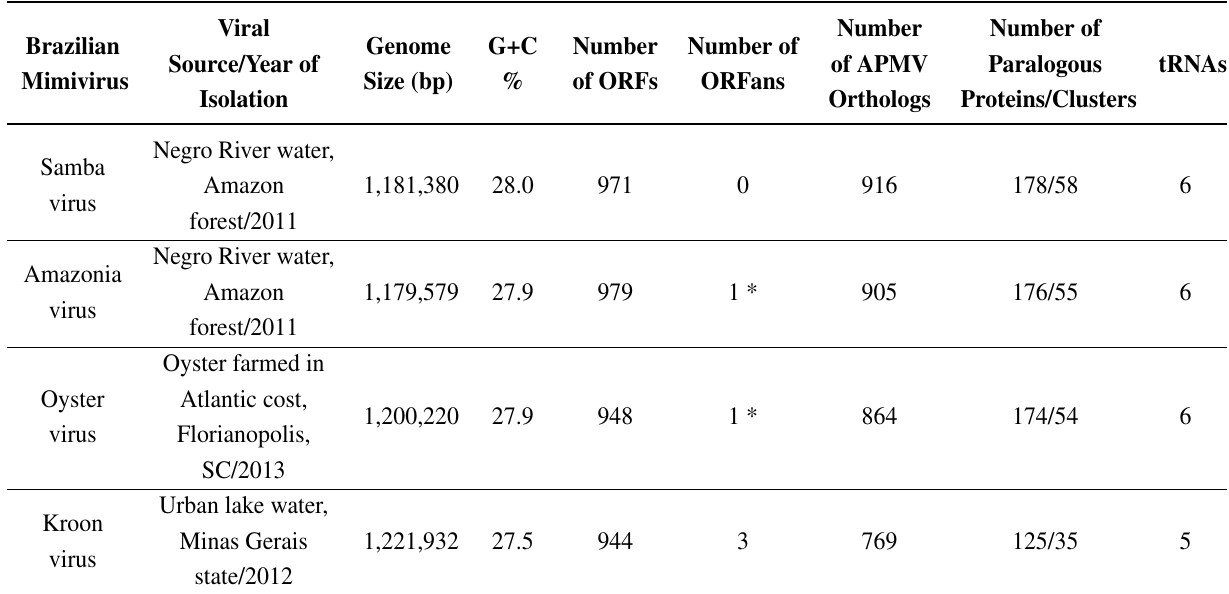
Table 1. Summary of results for genome annotation from Brazilian